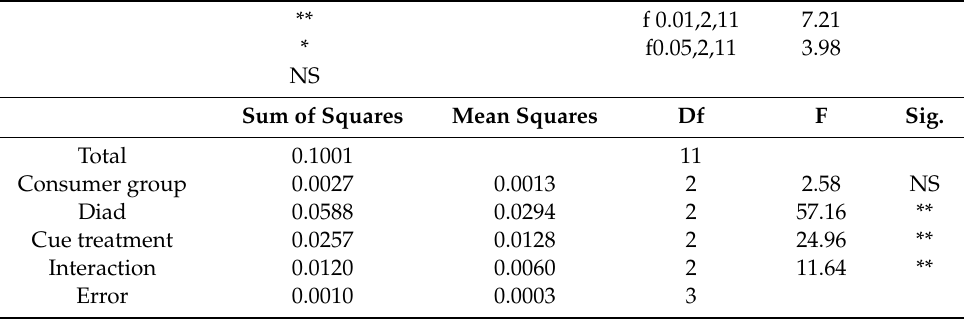
Table 1. Adjusted analysis of variance table after Youden and Hunter [55].